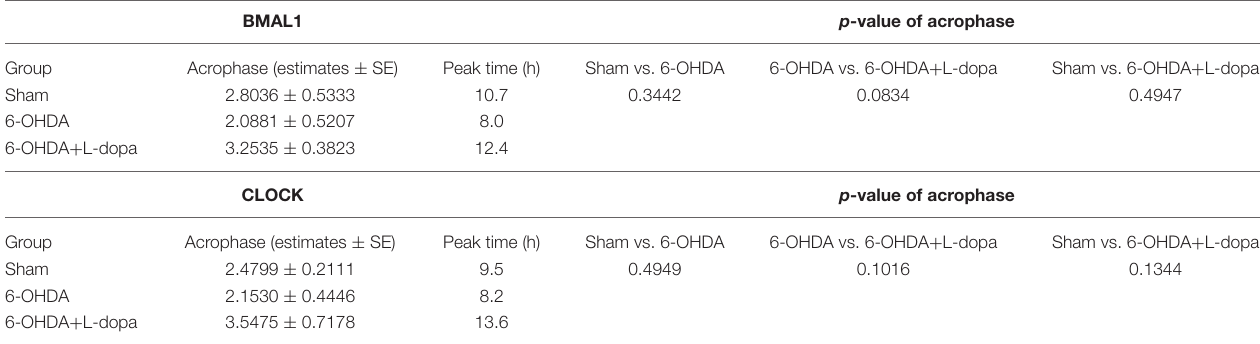
TABLE 3 | The acrophase and the corresponding peak time of BMAL1 and CLOCK protein expression by using the Cosinor model. BMAL1 p -value of acrophase